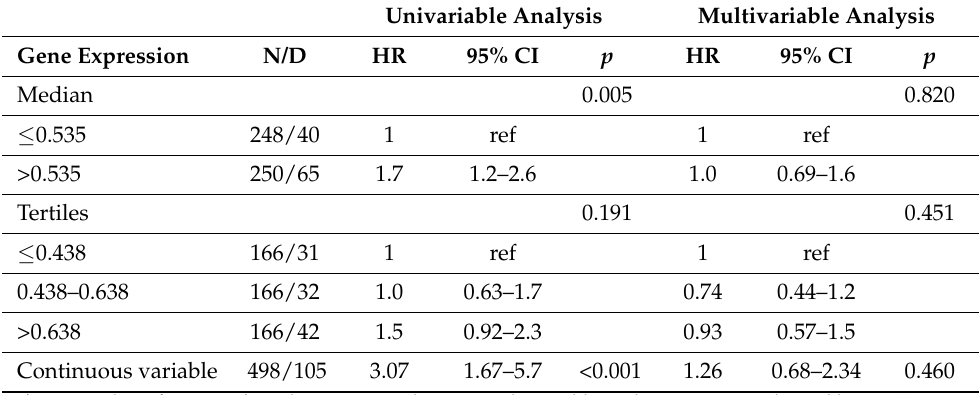
Table 8. Overall Survival of 498 NB patients in relation to LOC730811 expression levels evaluated by the Cox